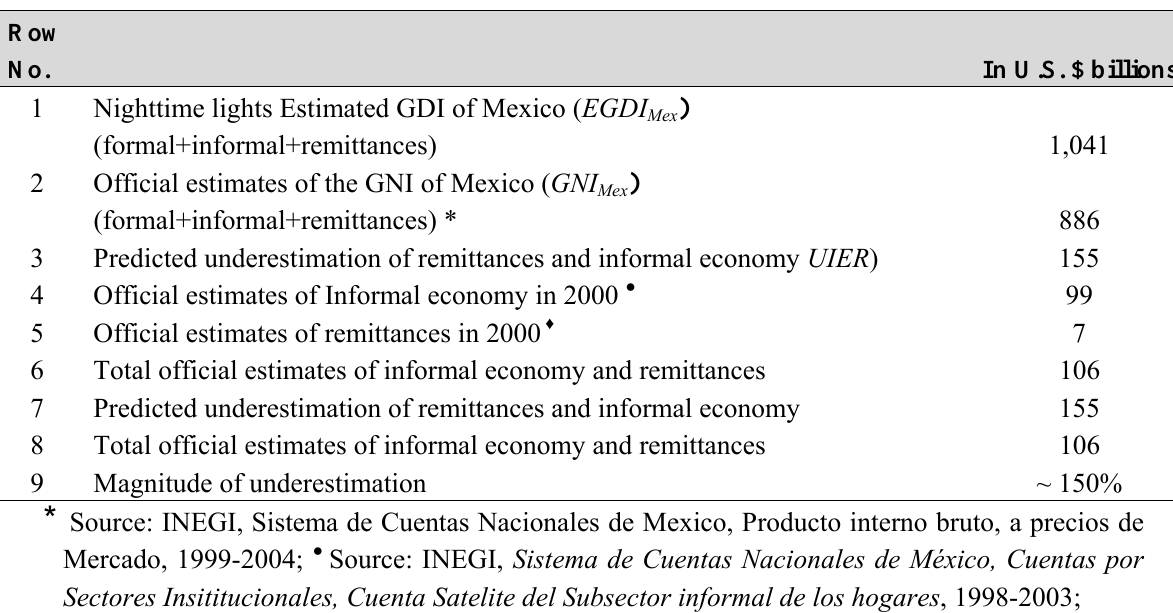
Table 7. Determining the magnitude of underestimation of informal economy and remittances in the official estimates of GNI of